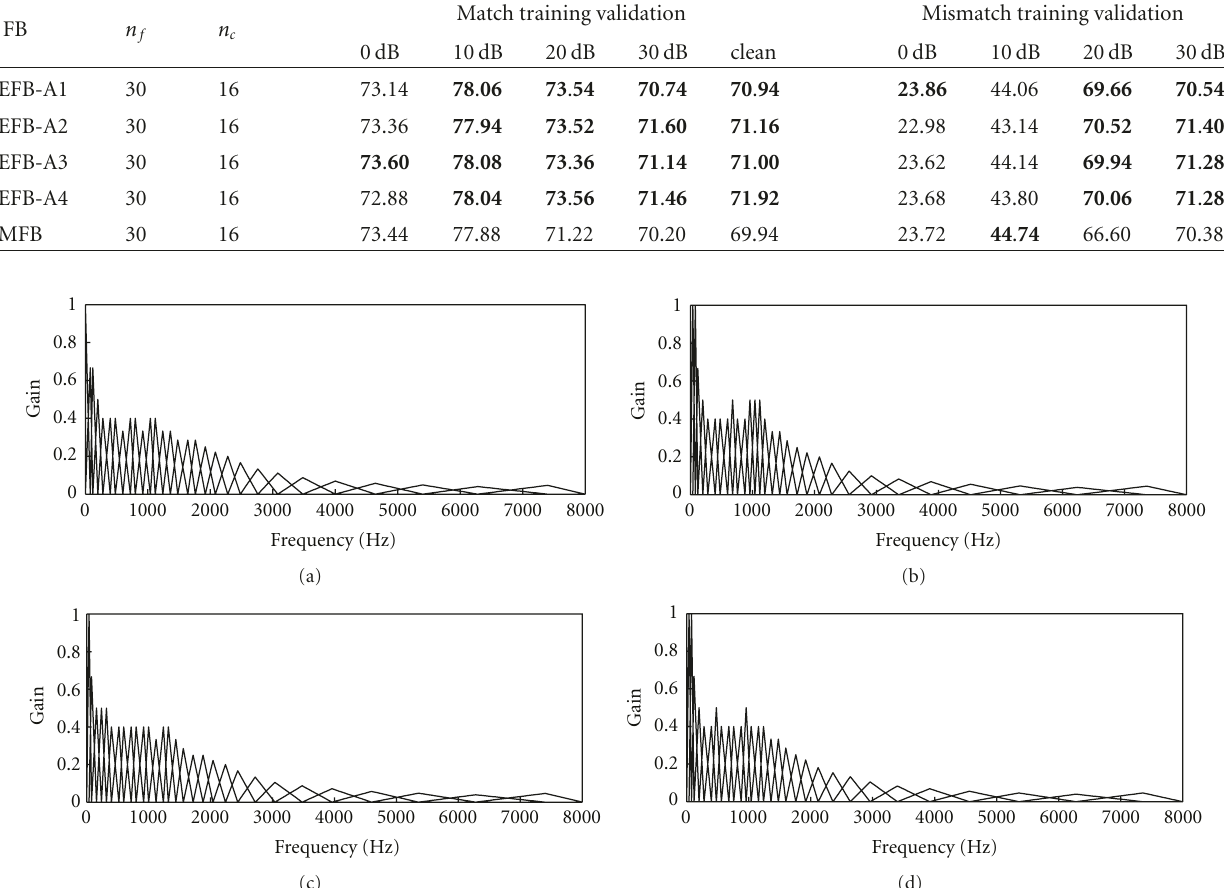
Table 1: Averaged validation results for phoneme recognition (shown in percent). Filterbanks are obtained from the optimization of filter center frequency values, while filter gains-scaled according to bandwidths and using clean signals.